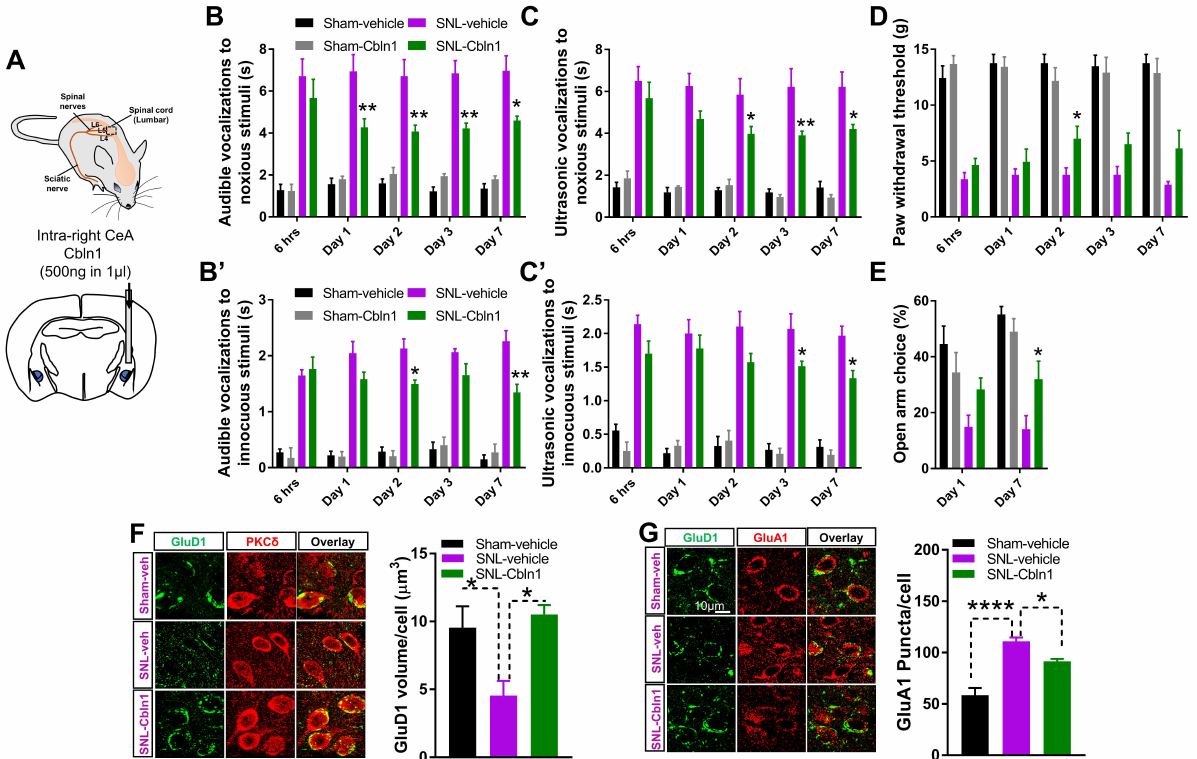
Figure 6. Recombinant Cbln1 rescues hypersensitivity and averse-affective behaviors in a neuropathic pain model. ( A ) Schematic representation of SNL model. The left L5 spinal nerve was ligated. Cbln1 (500 ng in 1 µ L) or PBS was injected into right CeA of SNL rat. ( B ) Intra-CeA Cbln1 showed reduction in noxious stimuli induced audible vocalization in SNL rats; n =